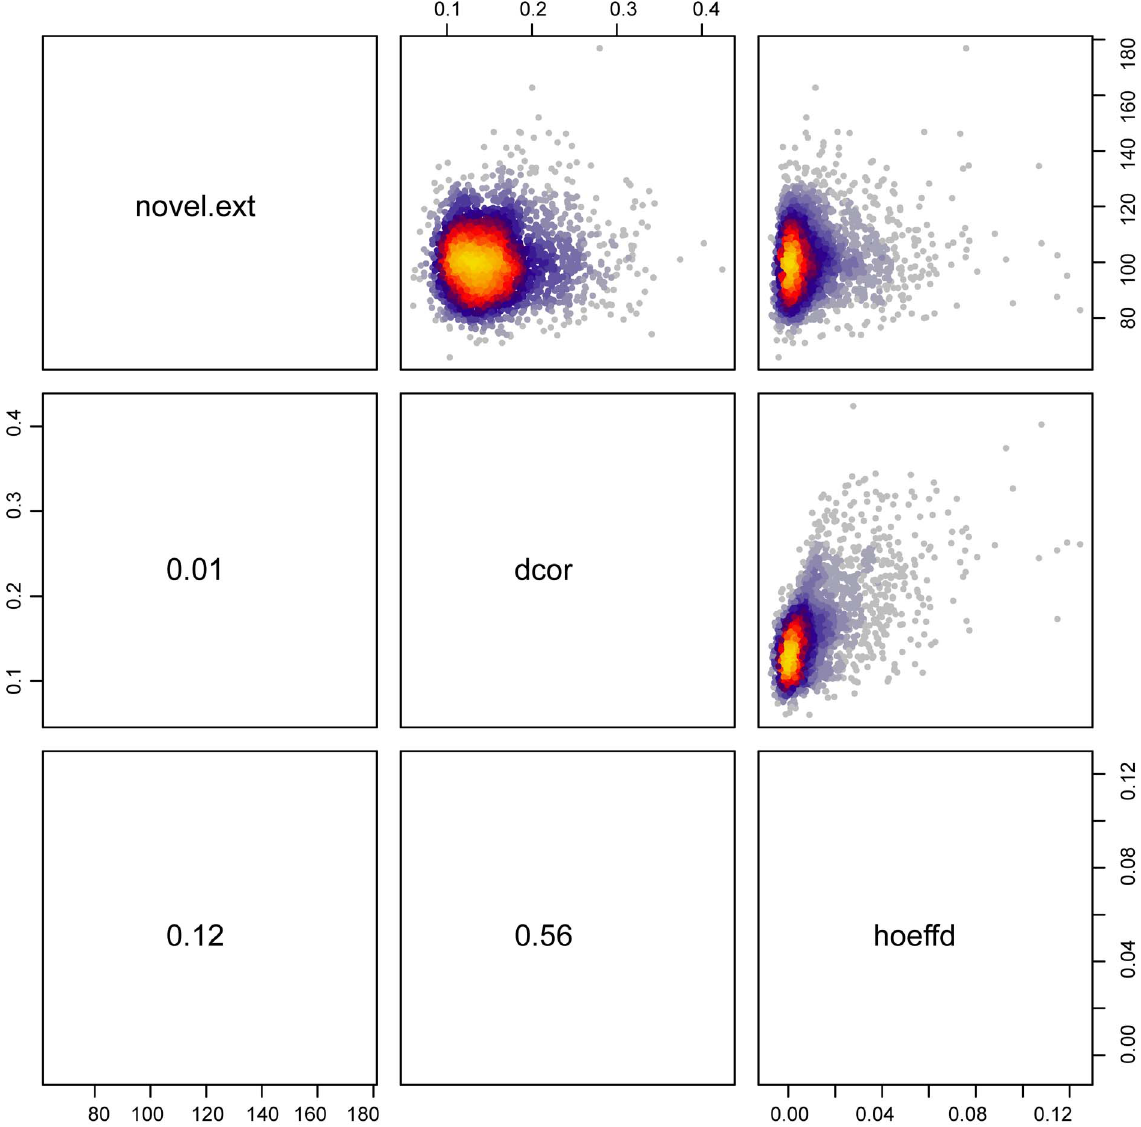
Figure 4. Performance on WHO data. novelTest.ext denotes our test based on extreme paths, dcor distance covariance and hoeffd Hoeffding’s D. All methods were applied to all comparison between pairwise variables which had Pearson’s product moment correlation coefficient near zero to exclude linear relationships. Only pairwise complete observations were used as most methods cannot handle missing vallues. All comparisons include ate least 81 datapoints. In total we compare all 3 methods on 2971 variable pairs.